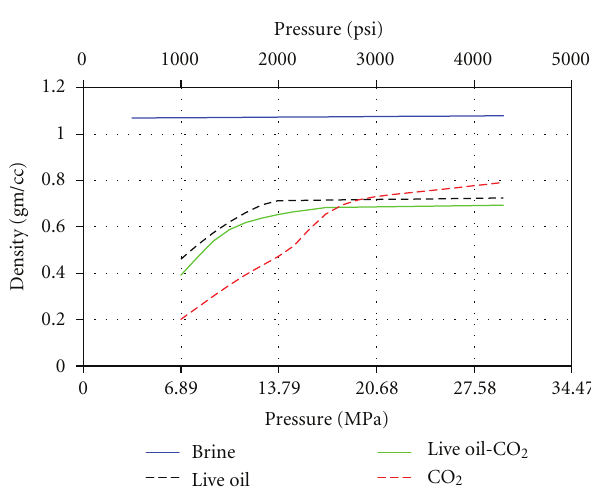
Figure 4: Fluid density as a function of pressure, modeled using the FLAG calculator [11].